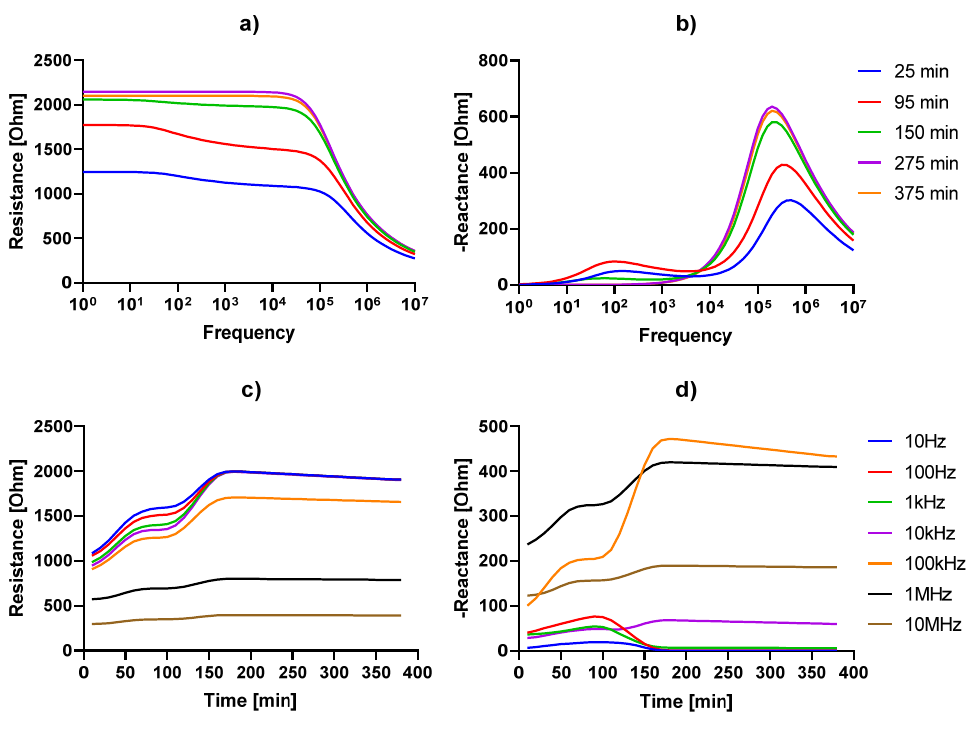
Figure 3. Simulated liver resistance and reactance profiles during ischemia.